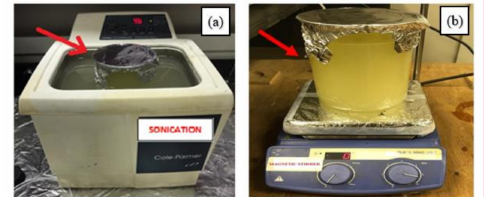
Figure 5. The preparation of the Minimum Quantity Lubrication (MQL)with nanoparticles ( a ) sonication and ( b ) magnetic stirring process of the